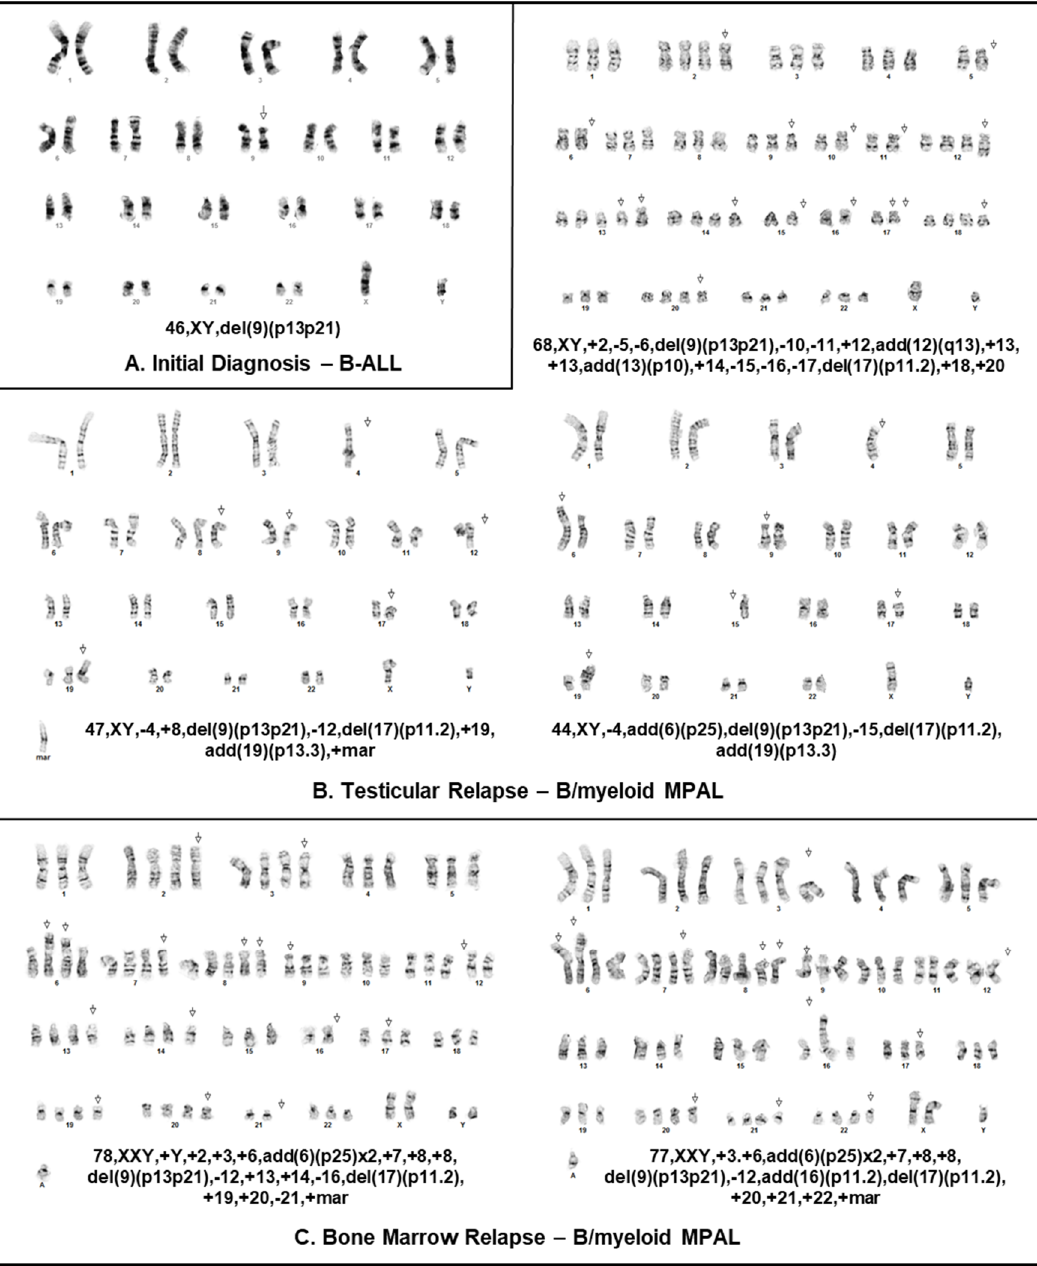
Figure 3. Karyotype of patient’s leukemia at various time points and across different sites of disease. ( A ) Cytogenetic analysis of B-ALL blasts at diagnosis obtained from a bone marrow aspirate and demonstrating 46,XY,del(9)(p13p21) in all cells analyzed. ( B ) Cytogenetic analysis of biopsy sample obtained from testicular relapse also demonstrating the del(9)(p13p21) in most cells analyzed among additional anomalies. ( C ) Cytogenetic analysis of MPAL blasts at marrow relapse obtained from a bone marrow aspirate and demonstrating hyperdiploidy, del(9)(p13p21) and additional